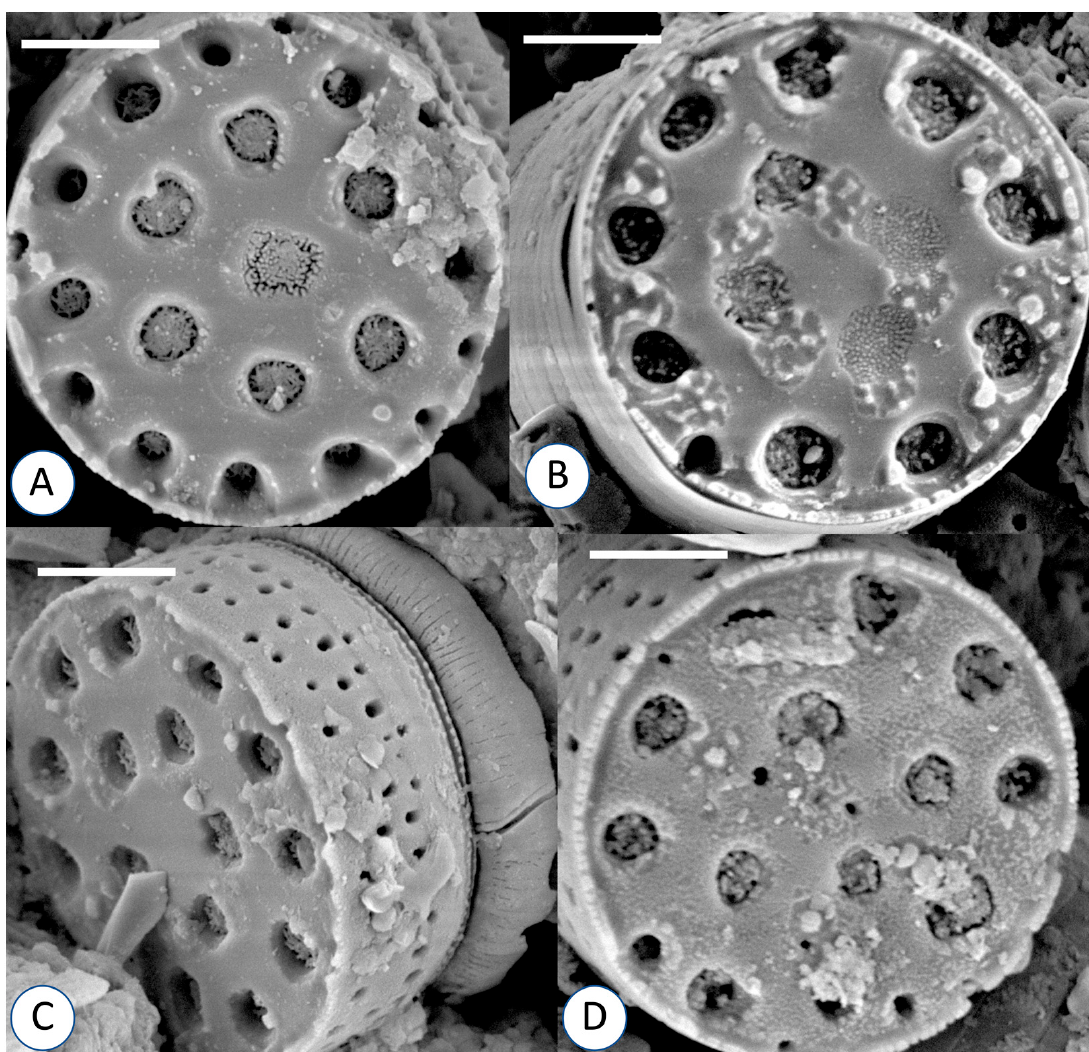
Figure 2. ( A – D ) Aulacoseira wyomingensis , sp. nov. Scanning electron microscopy. External valve views. Valve face is composed of areolae in deep depressions on the valve face, with covering at the base of each areola. In some cases, the areolae appear as depressions, without communication to the valve interior. Spines are mostly lacking. Scale bars = 2.5 µm.